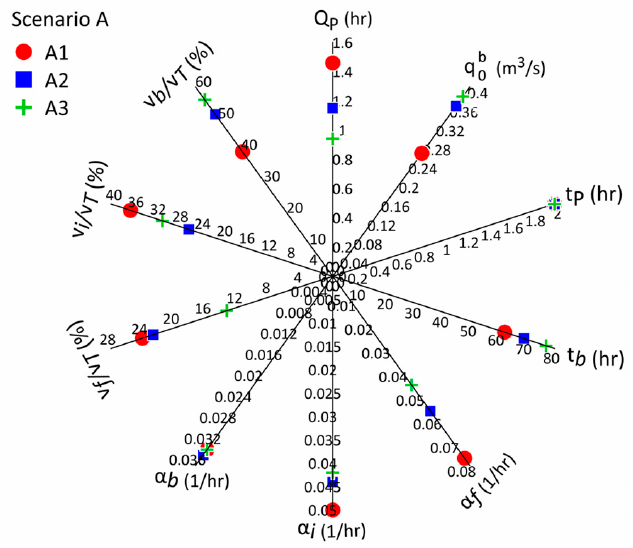
Figure 13. Comparison of different spring hydrograph characteristics in scenario A.